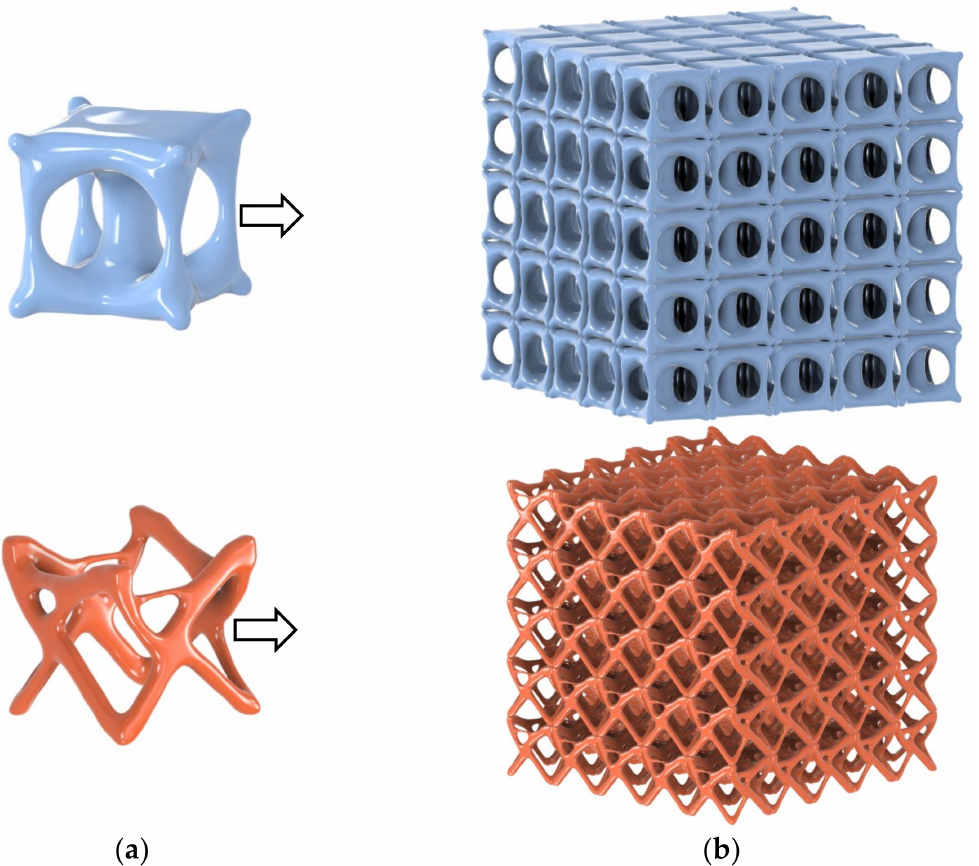
Figure 7. ( a ) Refined unit cell structures. ( b ) Mapping of the 5 × 5 × 5 lattice